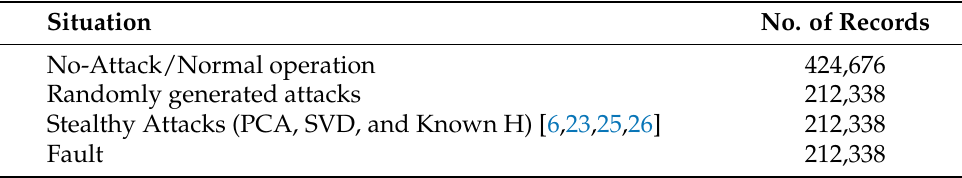
Table 1. Data for no-attack, cyber attack, and fault scenarios.